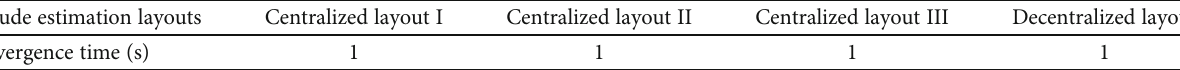
Table 4: Convergence time.